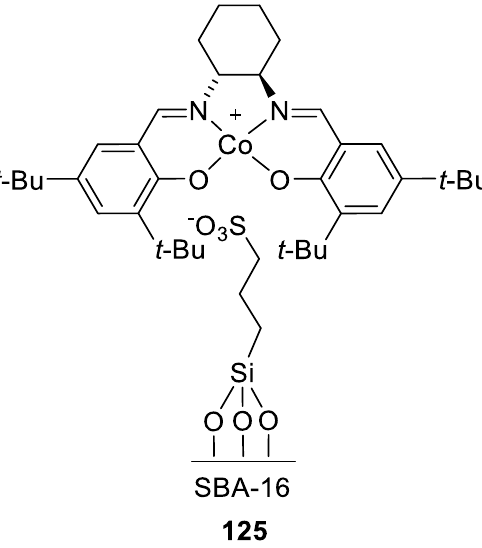
Figure 48. SBA-16-supported Co–salen catalyst 125 .